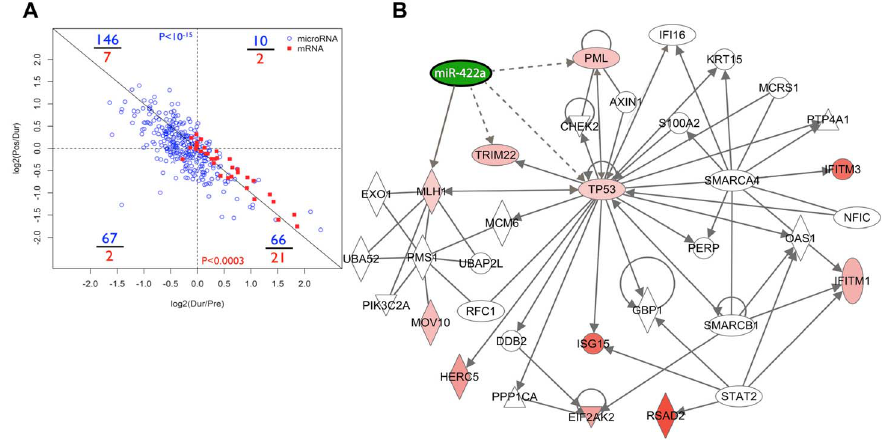
Figure 3. Visualization of miRNA and mRNA regulatory networks. (A) Plot of global miRNA and anti-HIV-1 restriction factor responses to IFN- a /RBV treatment. Numbers in blue and red represent tallies of microRNAs and restriction factor mRNAs in each quadrant, respectively. P-values were obtained using Fisher’s exact tests. (B) Integrative bioinformatic analyses of our miRNA data, restriction factor, MLH1 and TP53 mRNA profiles within the context of gene regulatory networks. Ingenuity Pathway Analysis (IPA) software was implemented to create the network